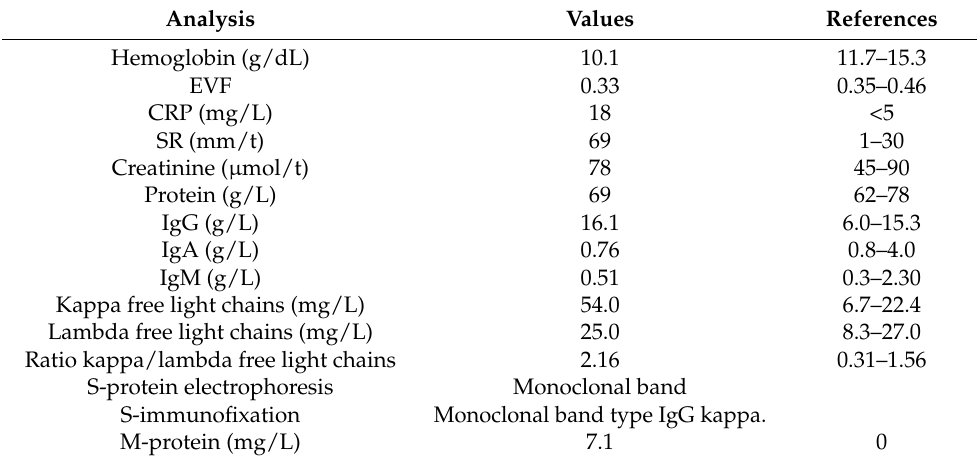
Table 1. Diagnostic blood test from the